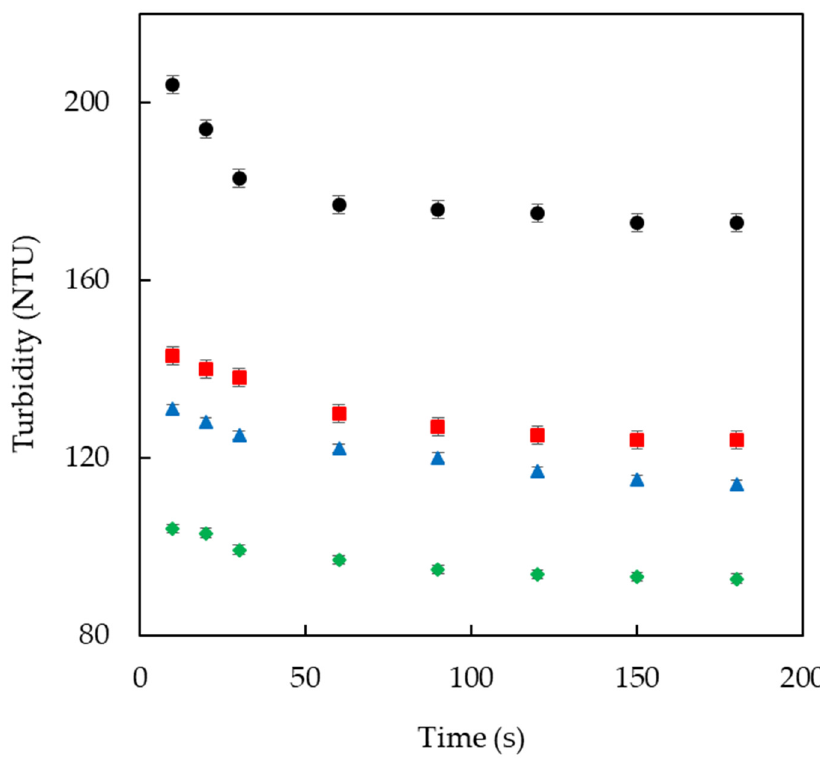
Figure 6. Plots of turbidity versus dissolution time of agglomerated guar gum (GG) with various concentrations of sucrose binder: ( • ) GG—0%, ( (cid:4) ) GG—10%, ( (cid:78) ) GG—20%, and ( (cid:4) ) concentrations of sucrose binder: ( ● ) GG–0%, ( █ ) GG–10%, ( ▲ ) GG–20%, and ( ◆ ) GG–30%.